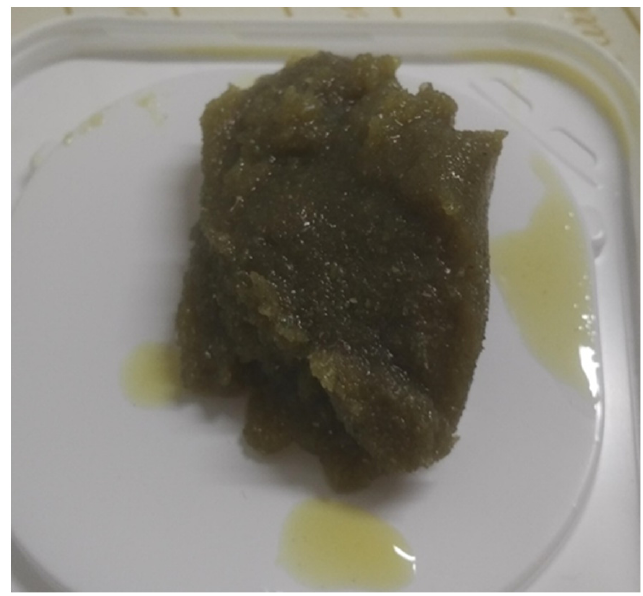
Figure 5. Fine sample of polyurethane foam soaked with 20w50 oil after oil sorption long test.